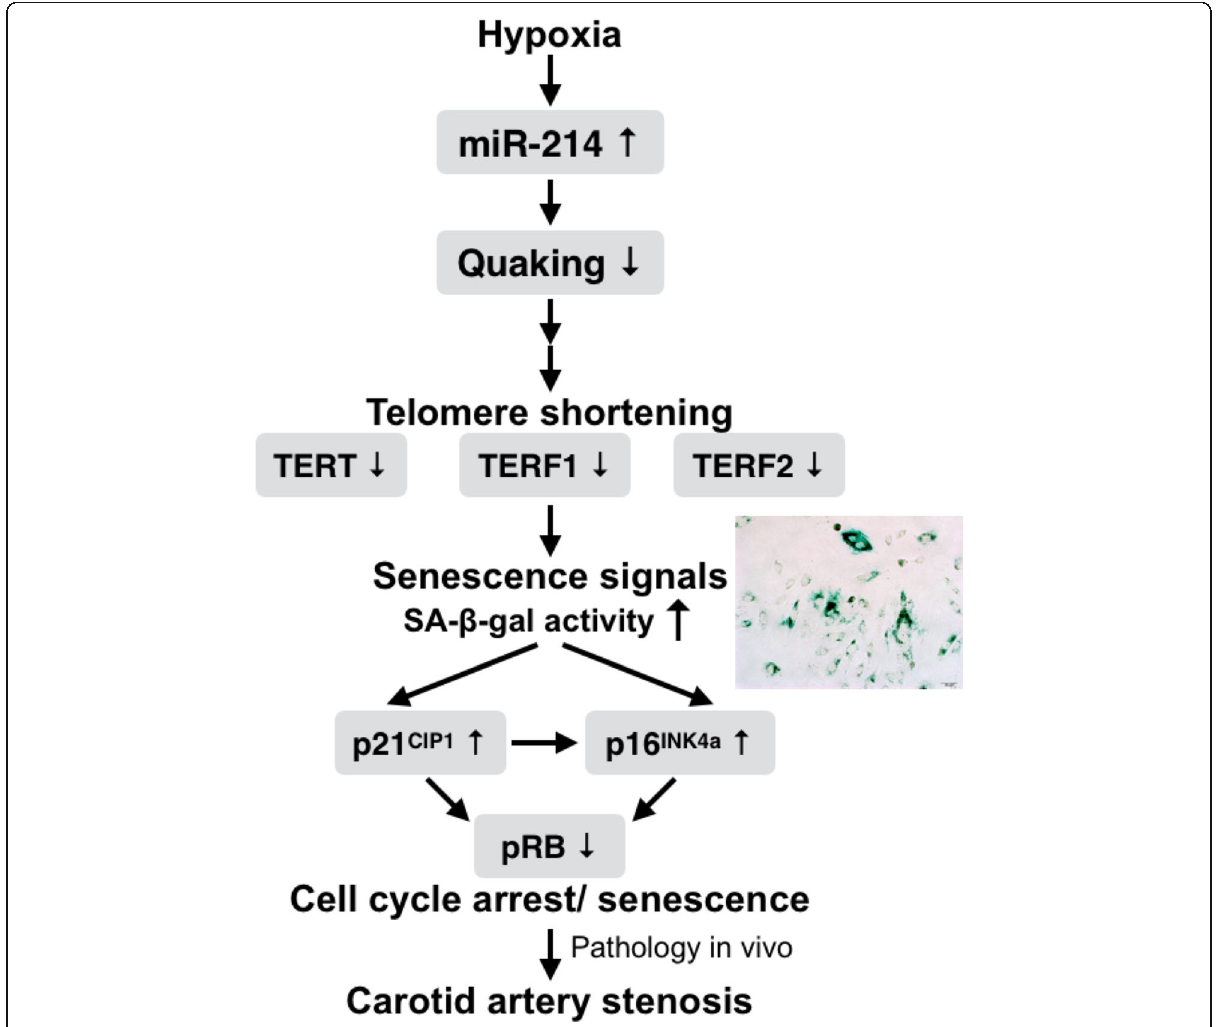
Fig. 7 Schematic diagram represents the proposed mechanism of action of microRNA-214 (miR-214) in senescent VSMCs. In response to hypoxia- induced oxidative stress, hypoxia-induced microRNA-214 were overexpresed and promoted A7r5 VSMCs enter a senescent state. In senescent VSMCs, miR-214 targeted quaking to trigger loss of telomere integrity, upregulation of the cell cycle inhibitors p16 INK4 and/or p21 CIP1 , and accumulation of senescence-associated β -galactosidase (SA- β -Gal). Therefore, miR-214 appeared to induce VSMC senescence and cell death, further jeopardize plaque stability in carotid artery stenosis. Arrows ( — >) indicated molecular interaction or relation with